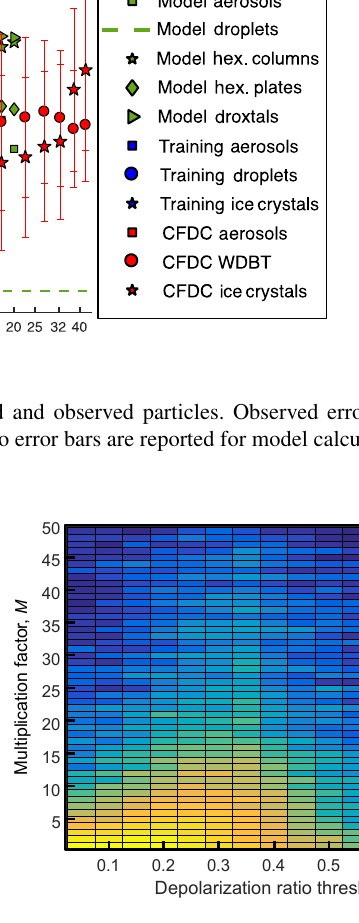
Figure 7. R 2 values for linear regression fit as a function of depolar- ization ratio threshold for optimizing ice crystal differentiation and water droplet and/or aerosol concentration multiplication factor, M